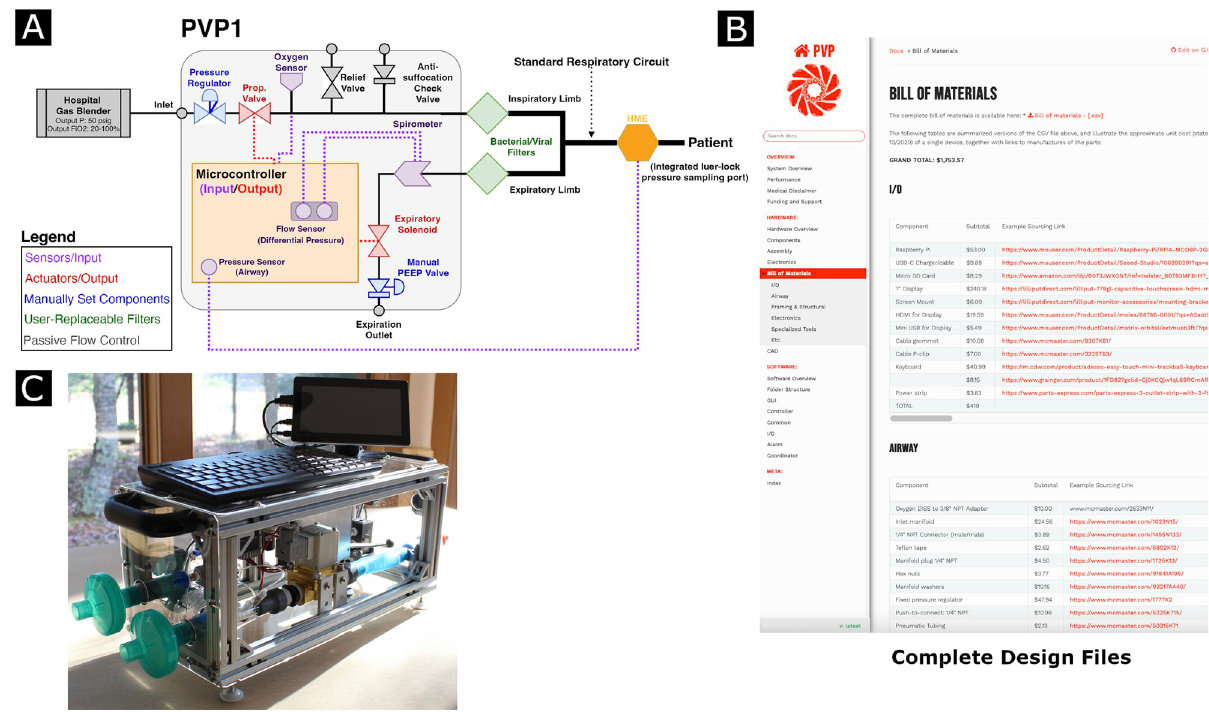
Fig 1. A system overview of the People’s Ventilator Project. A Overview of respiratory circuit. B A snapshot of the online documentation in the form of a web-portal containing documentation and detailed build instructions. PVP1 Bill of Materials is highlighted. C The assembled device.